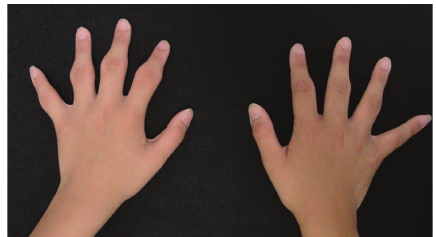
Figure 1: Photographic image of bilateral hands. Symmetrical swelling around PIP joints of bilateral digits